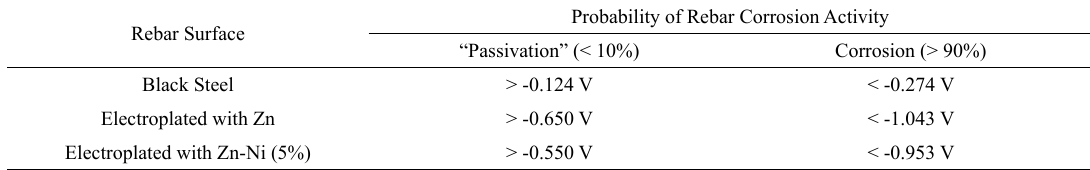
Table 1. Probability of rebars corrosion activity as a function of ranges of corrosion potential for ordinary (black steel) rebars and rebars electroplated with zinc and zinc-nickel alloys (reference: saturated calomel electrode, SCE) Rebar